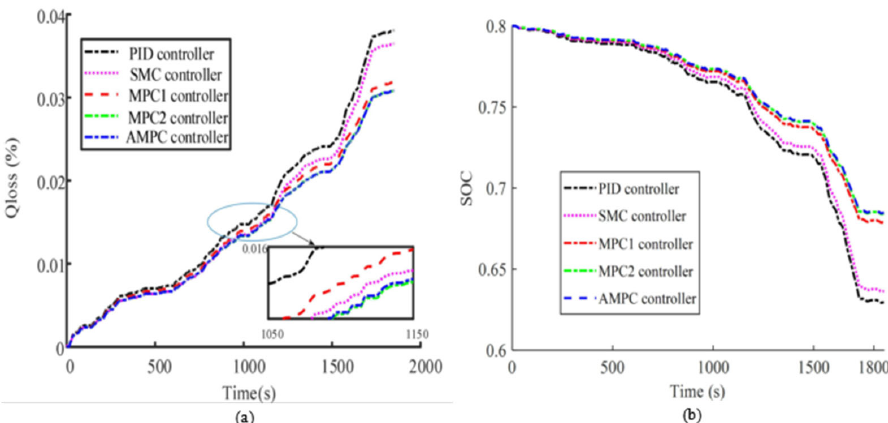
Figure 13. Under WLTC working conditions, the battery (SOHini = 1) parameters under the action of each controller: ( a ) battery capacity loss ( b ) SOC.